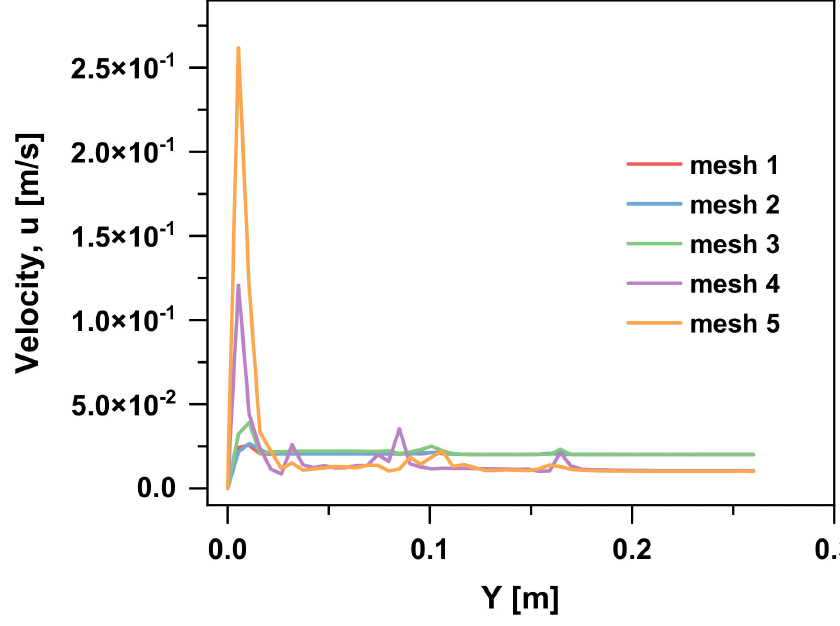
Figure 4. Velocity of the flow along y-axis of bubble rising trajectory at 5